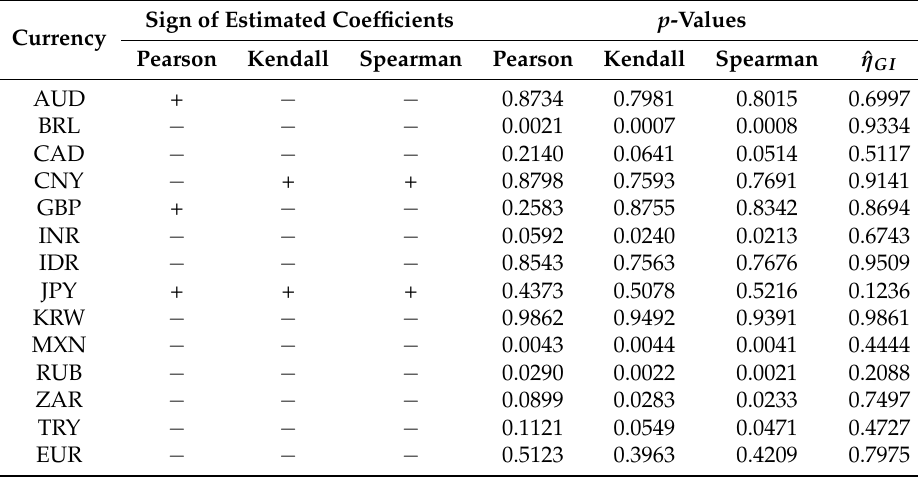
Table 5. The sign of Estimated Correlation Coefficients and p -values of correlation tests between the standardized residuals of SAR and those of the other 14 currencies based on Pearson’s product moment correlation coefficient, Kendall’s τ and Spearman’s ρ , respectively. The last column is the p -values of the test of H 0 using the OLS test